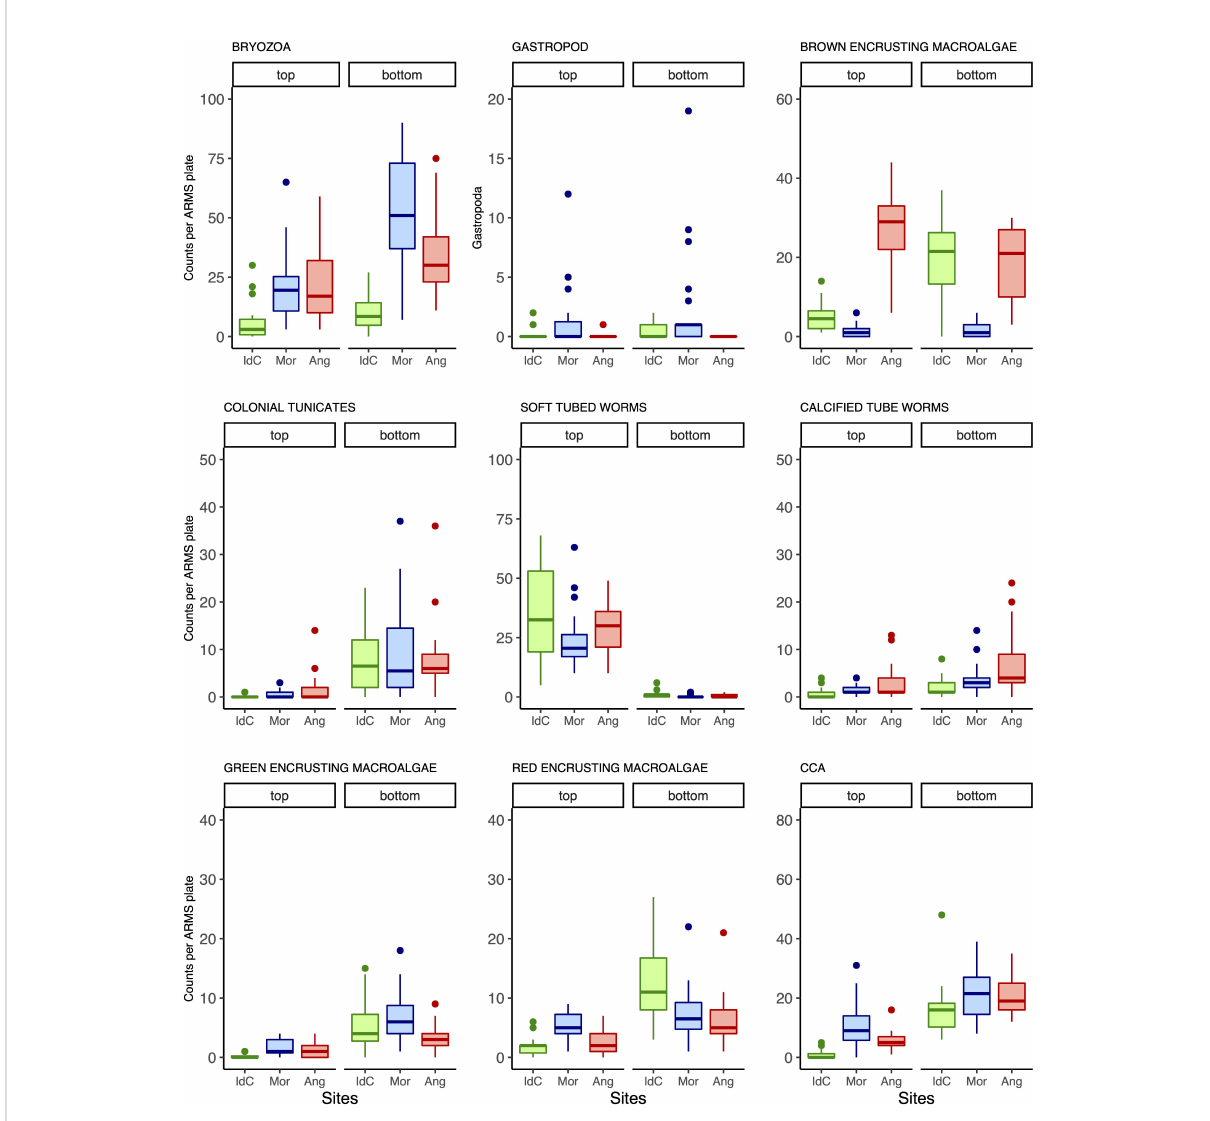
FIGURE 7 Boxplots comparing the counts of nine taxonomic groups were found to have signi fi cantly different abundances across autonomous reef monitoring structures (ARMS) plate face and/or across sampling sites (IdC, Ile du Coin; Mor, Moresby; and Ang, Ile